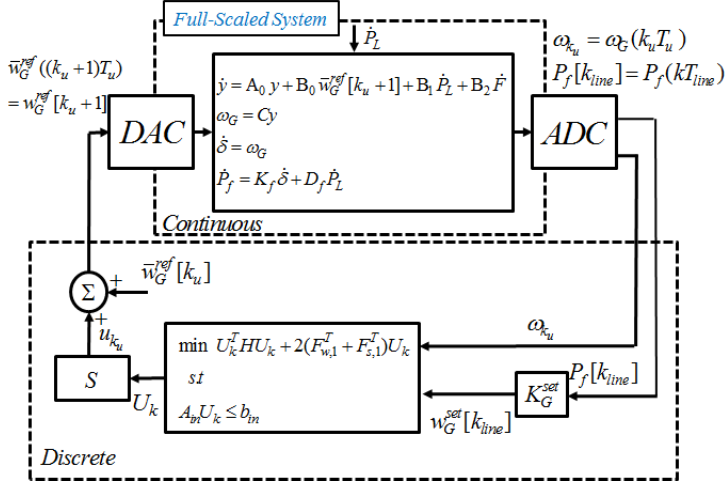
Figure 1. Centralized MPC-based AGC Considering